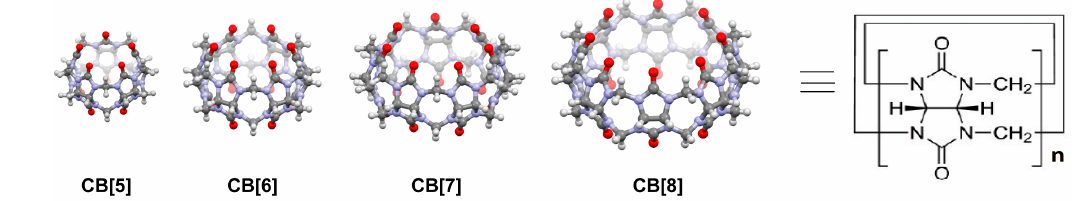
Figure 1. Structures of cucurbit[ n ]urils (CB[ n ]s, n = 5–8 ).